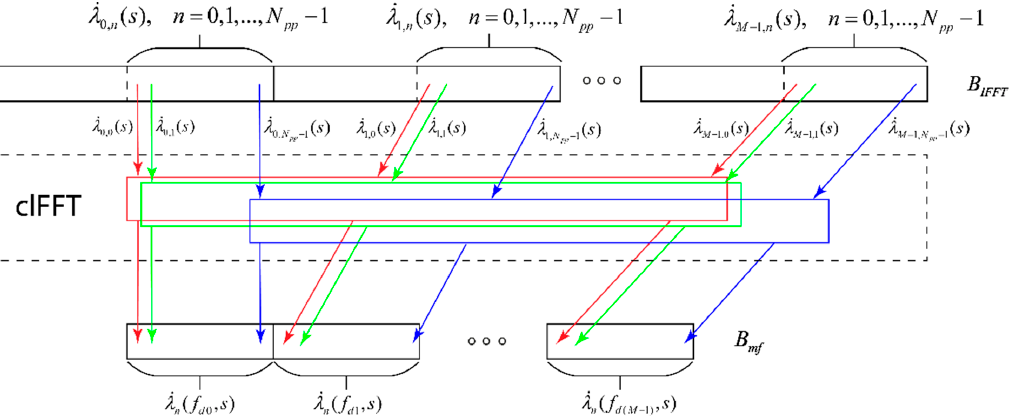
Figure 8. Scheme of the module for taking into account Doppler frequency shifts and obtaining the total decisive statistics, implemented through the